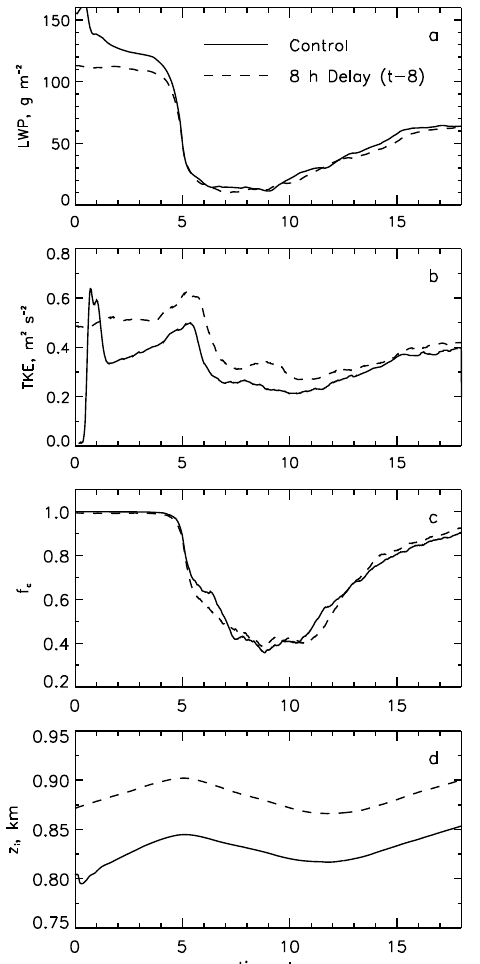
Figure 14. Investigation of importance of timing of N perturbation. Solid line: control case; dashed line: control case but with N per- turbation delayed by 8h during which time the boundary layer has deepened (time axis shifted so N perturbation coincides). In both cases LWP and f c recovery are similar.